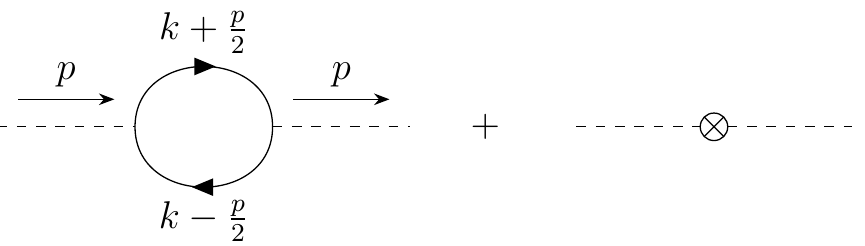
Figure 1 . Self energy calculation at one-loop order. The solid (dashed) line represents fermion (scalar)